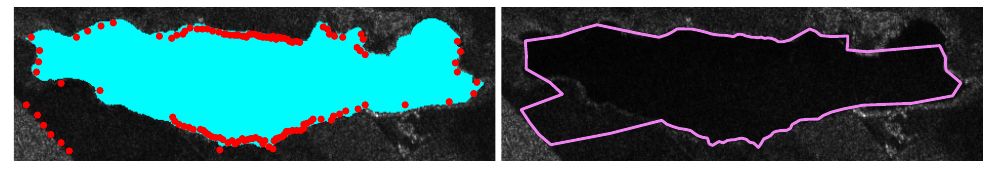
Figure 10. Results of JS with n r = 126 when the proposed algorithm is applied to the third lagoon in Figure 3